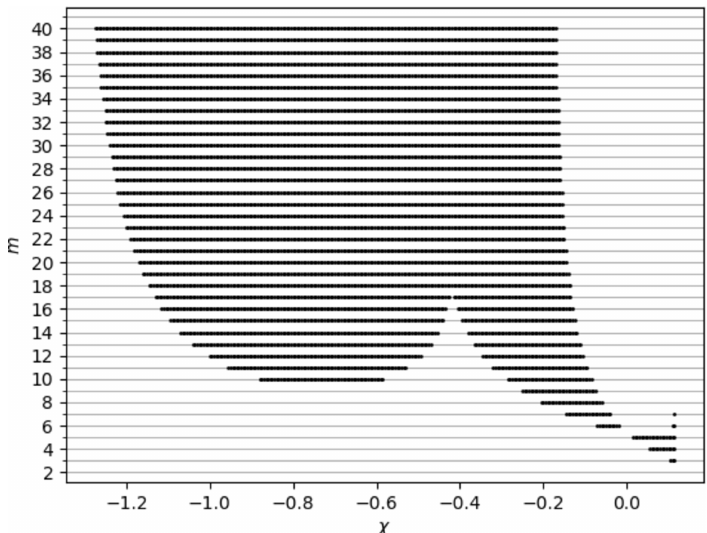
Figure 16 . The predicted regions of instability for a model with η φ = 1 , η σ = 0 . 35 , λ φ = 1 , λ σ = 36 , β 0 = 6 . 6 , G = 0 . 2 (parameter set F) and a modified interaction term V int = β 0 | σ | 2 | φ | 6